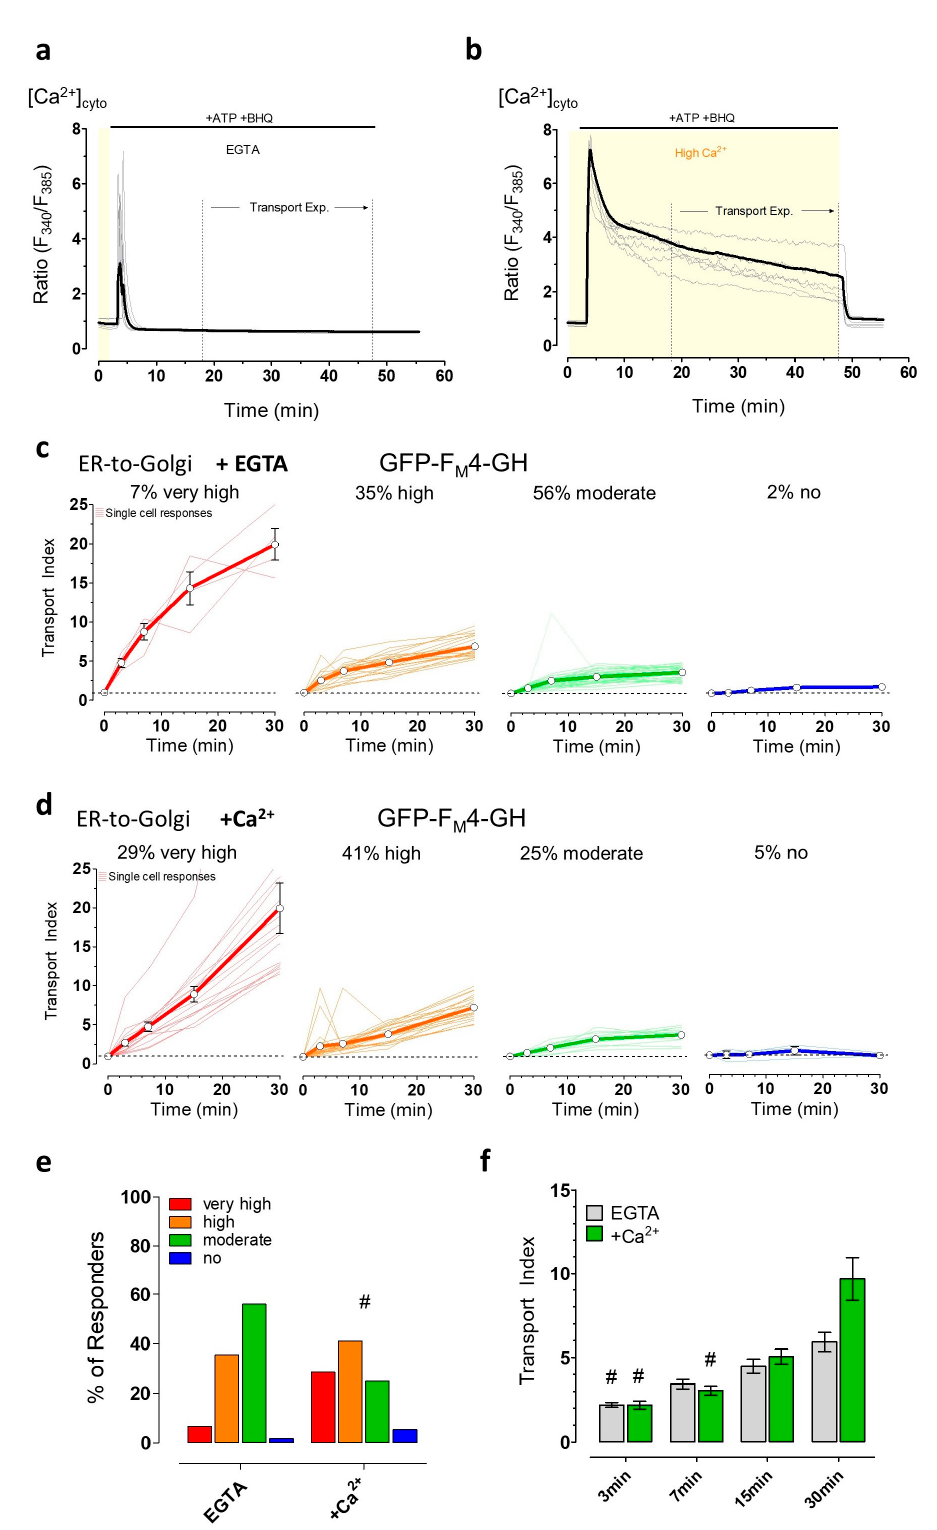
Figure 6. ER-to-Golgi transport of soluble cargo is affected by short-term calcium mobilization in HeLa cells. ( a and b ) Curves showing changes in Fura-2 ratio (i.e., cytosolic Ca 2+ concentrations) over time upon Ca 2+ mobilization using 100 μ M ATP and 15 μ M BHQ in the absence of extracellular Ca 2+ (i.e., 0.1 mM EGTA, n = 53 cells from three independent experiments) (a) and presence of 2 mM Ca 2+ (n = 66 cells from three independent experiments) (b). The respective time frame after Ca 2+ mobilization for transport experiments ( c – f ) is indicated with dotted lines (“Transport Exp.“). (c) Curves represent very high, high, moderate, and no ER-to-Golgi transport of GFP-F M 4-GH in single HeLa cells (n = 59 cells from 3 independent experiments) after 15 min of Ca 2+ -mobilization in EGTA;